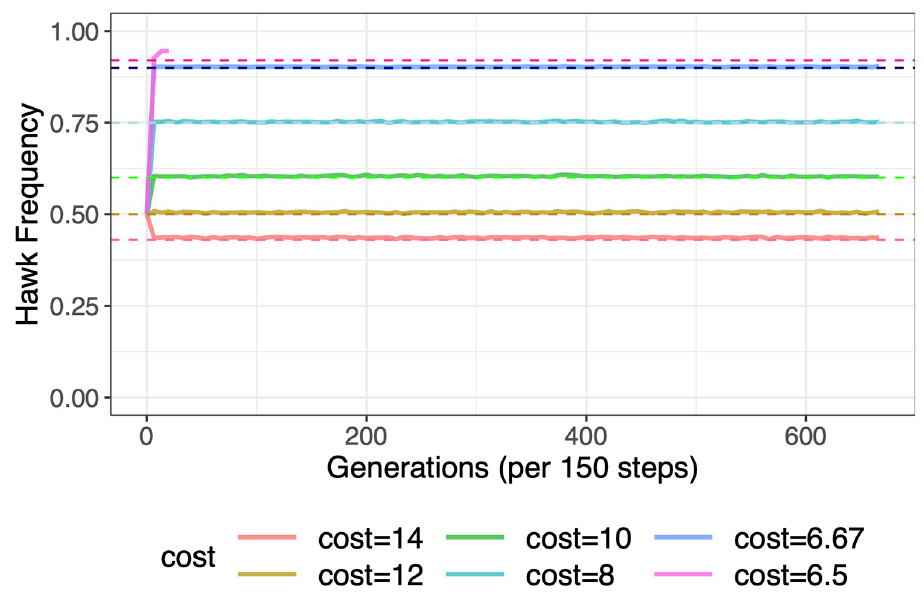
Fig 2. Validation simulations of theoretical evolutionary stable state (ESS) in hawk-dove game. The hawk frequencies evolved to the predicted b / c when c > b , except when b / c > 0.9. Dashed lines indicate the theoretically predicted hawk frequencies, b / c . The benefit was held constant b = 6 across all simulations. The cost, c , was varied, c = 14, 12, 10, 8, 6.67, and 6.5, with predicted hawk frequencies of b / c = 0.43, 0.5, 0.6, 0.75, 0.9, and 0.92, respectively.